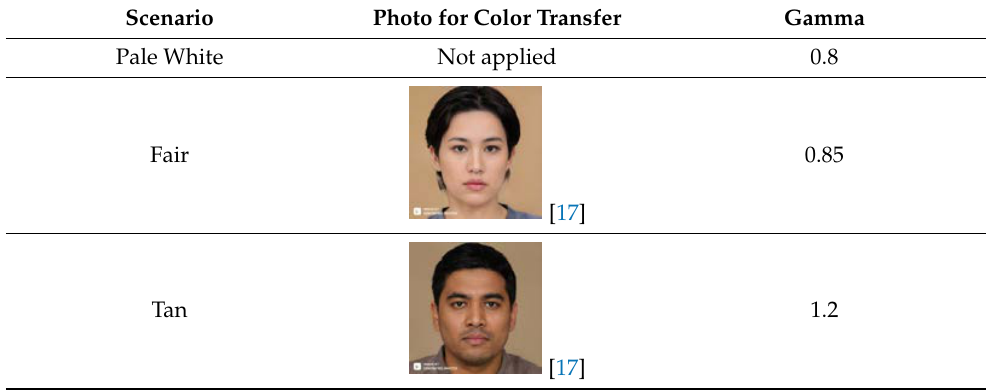
Table 1. Color Transfer Configuration. Photos by Generated Photos [17].